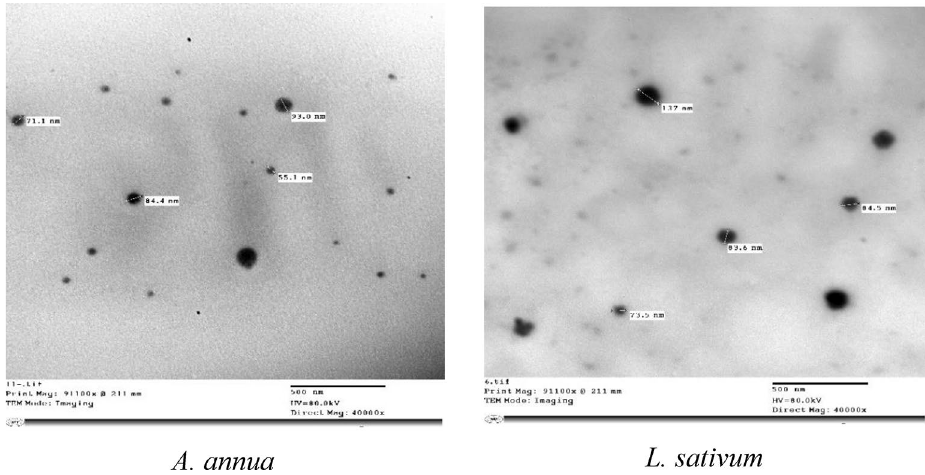
Figure 1. Transmission electron microscopy of the prepared A. annua and L. sativum